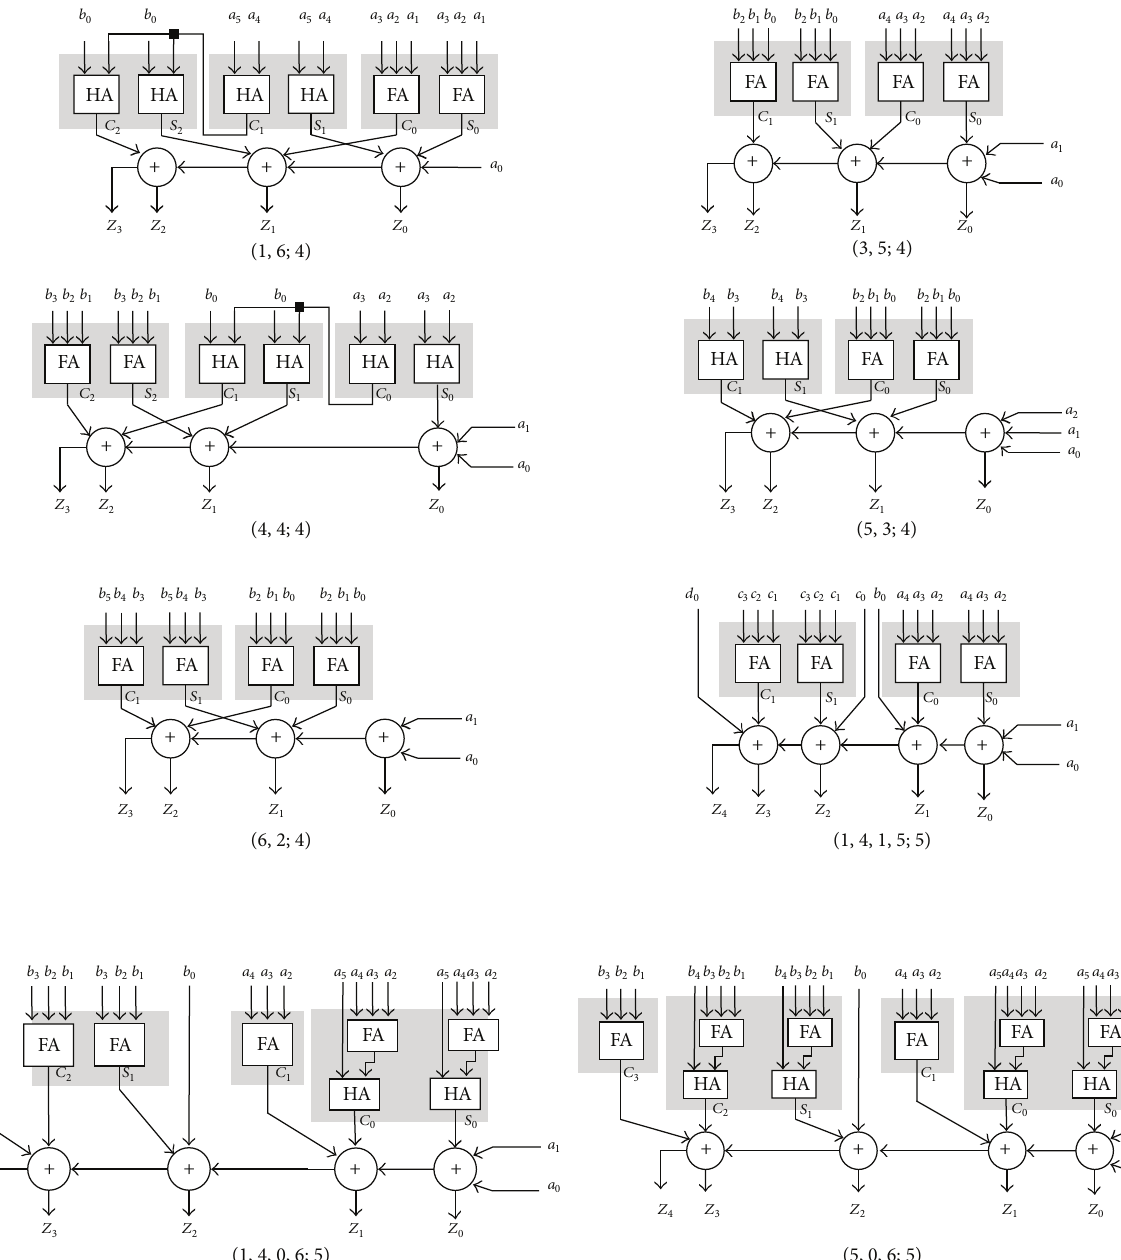
Figure 13: Area optimal mapping for different GPCs using proposed heuristic on Altera